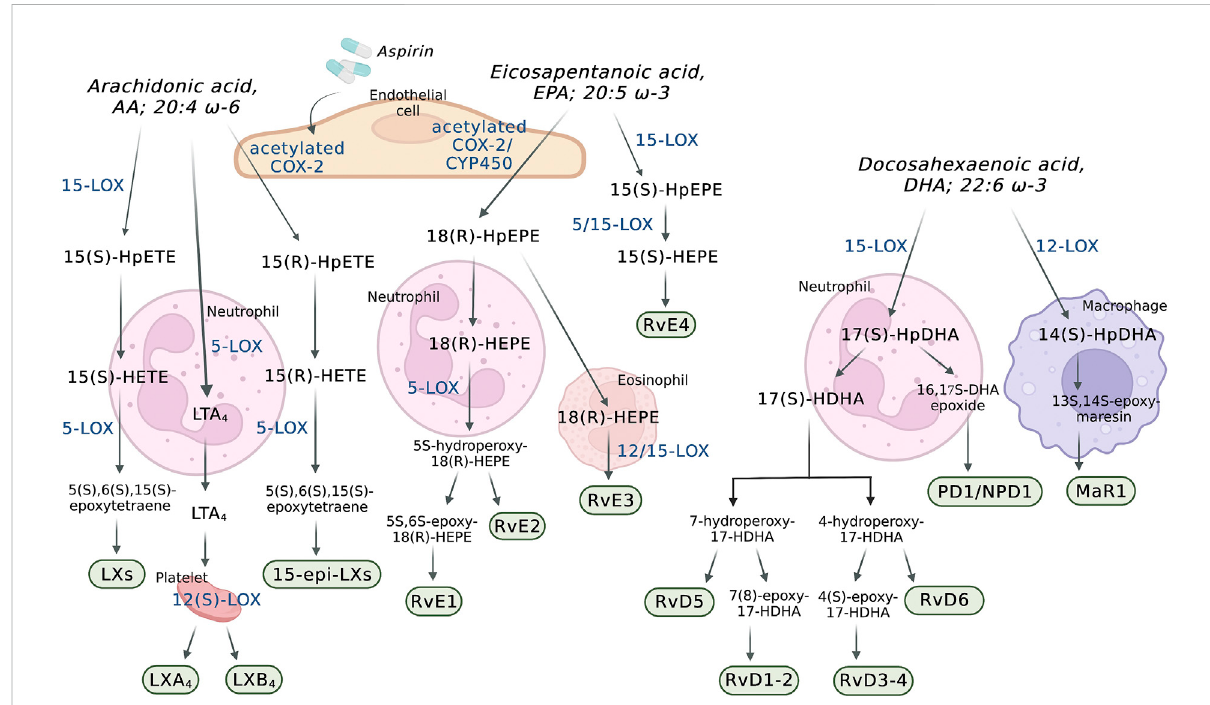
FIGURE 2 Transcellular biosynthesis of eicosanoids in the blood and the vascular wall. AA : arachidonic acid; COX-2: cyclooxygenase-2; CYP450: P450cytochromeepoxygenase ; DHA: docosahexaenoicacid ;EPA :eicosapentaenoicacid; LTA 4 :leukotrieneA 4 ; LXs: lipoxins; LXA 4 : lipoxinA 4 ; LXB 4 : lipoxin